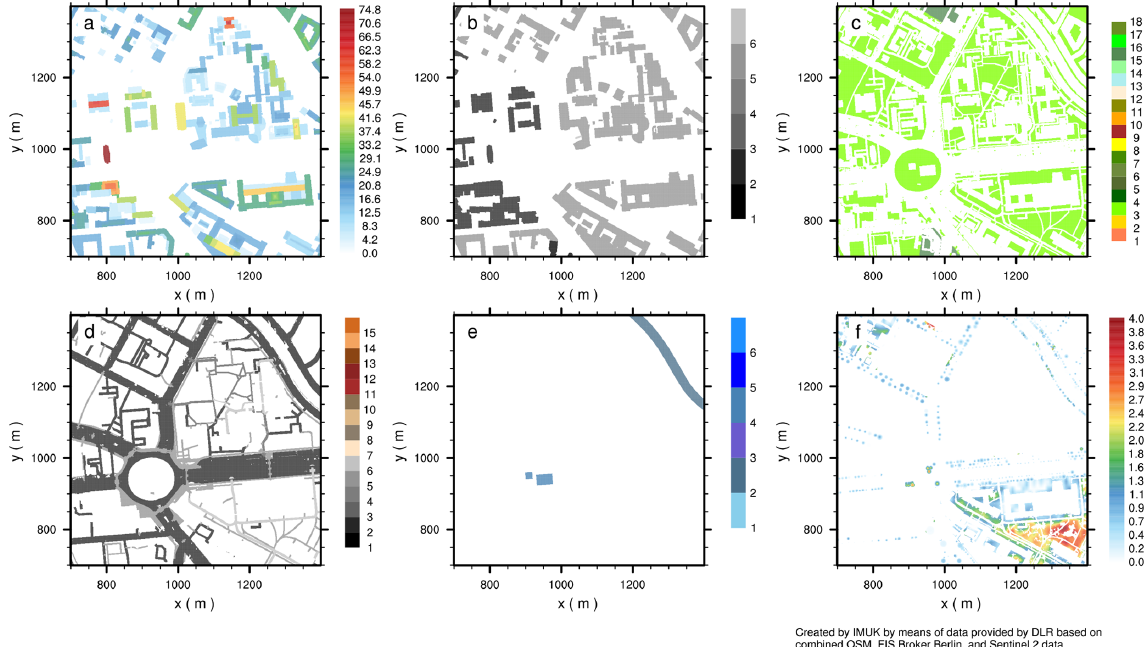
Figure 16. The x – y cross section of static input data for a nested simulation with 1m grid resolution for a winter scenario for an area around Ernst-Reuter-Platz in Berlin, Germany: (a) building height, (b) building type, (c) vegetation type, (d) pavement type, (e) water type and (f) leaf area index of resolved vegetation (trees). For the sake of illustration (f) displays the leaf area index instead of the leaf area density, with the leaf area index being the vertically integrated leaf area density. Please note in (b) – (e) the label bar contains all possible ∗ _type variables as indicated in Table A1, A2, A3 and A5, though only a few types are defined within the displayed area. Panel (b) displays building_type 1 (R1), 2 (R2) and 5 (O2). Panel (c) displays vegetation_type 3 (short grass) and 15 (evergreen shrubs). Panel (d) displays pavement_type 2 (asphalt), 3 (concrete), 4 (sett), 5 (paving stone) and 6 (cobblestone). Panel (e) displays water_type 2 (river) and 4 (pond). Sources: FIS Broker (dl-de/by-2-0: https://www.govdata.de/dl-de/by-2-0, last access: 26 October 2020), Sentinel-2 and OpenStreetMap.